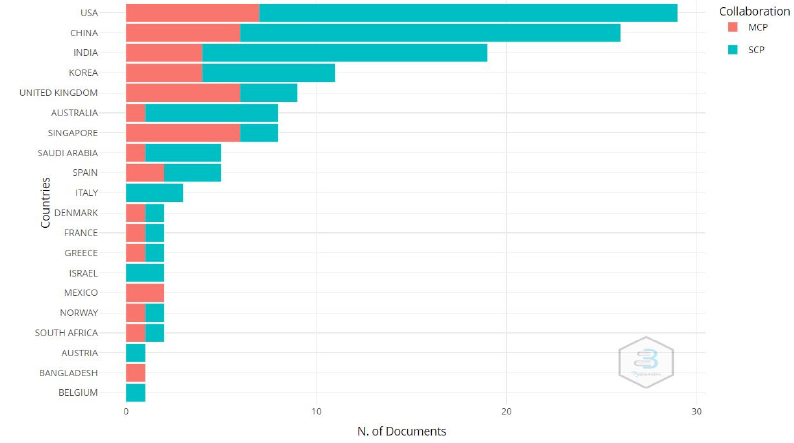
Figure 4. The most relevant countries based on the corresponding authors (SCPs (single country publications) and MCPs (multiple ‐ country publications)).